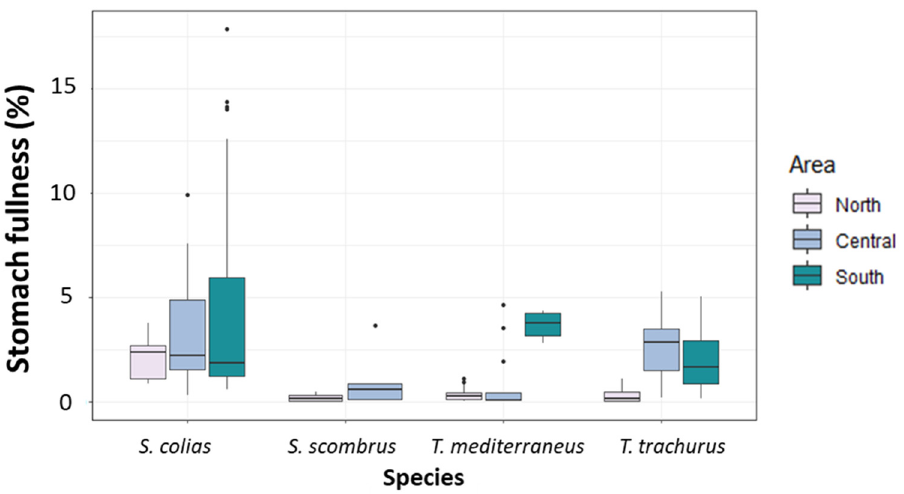
Figure 3. Boxplot of stomach fullness (%) measured in the specimens of the four “ancillary” species captured in the North, Central and South Adriatic Sea.